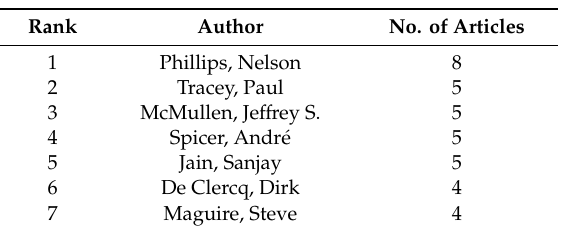
Table 5. Author productivity.